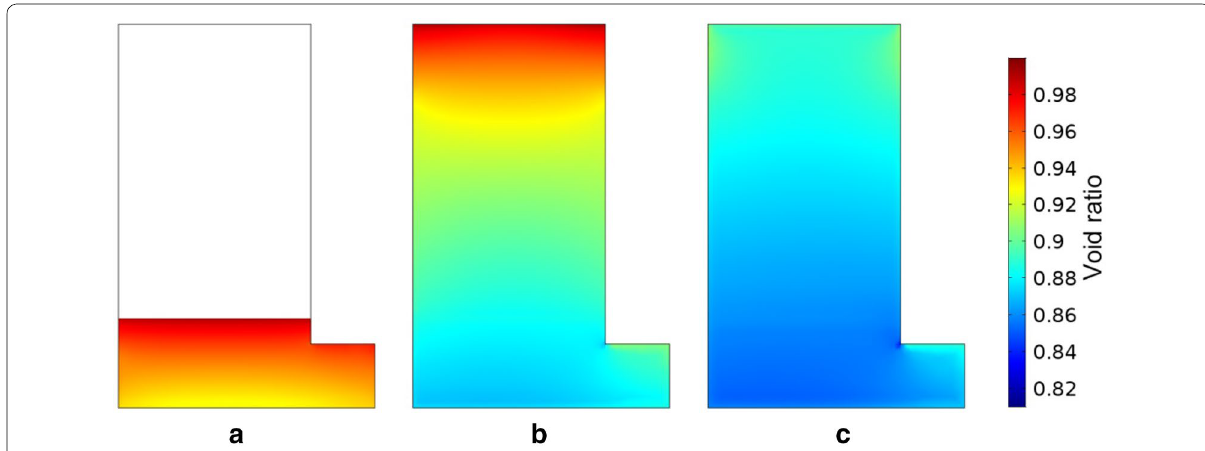
Fig. 12 Changes in void ratio with curing time: a 14 h (completion of plug filling); b 84 h (completion of filling operation); and c 168